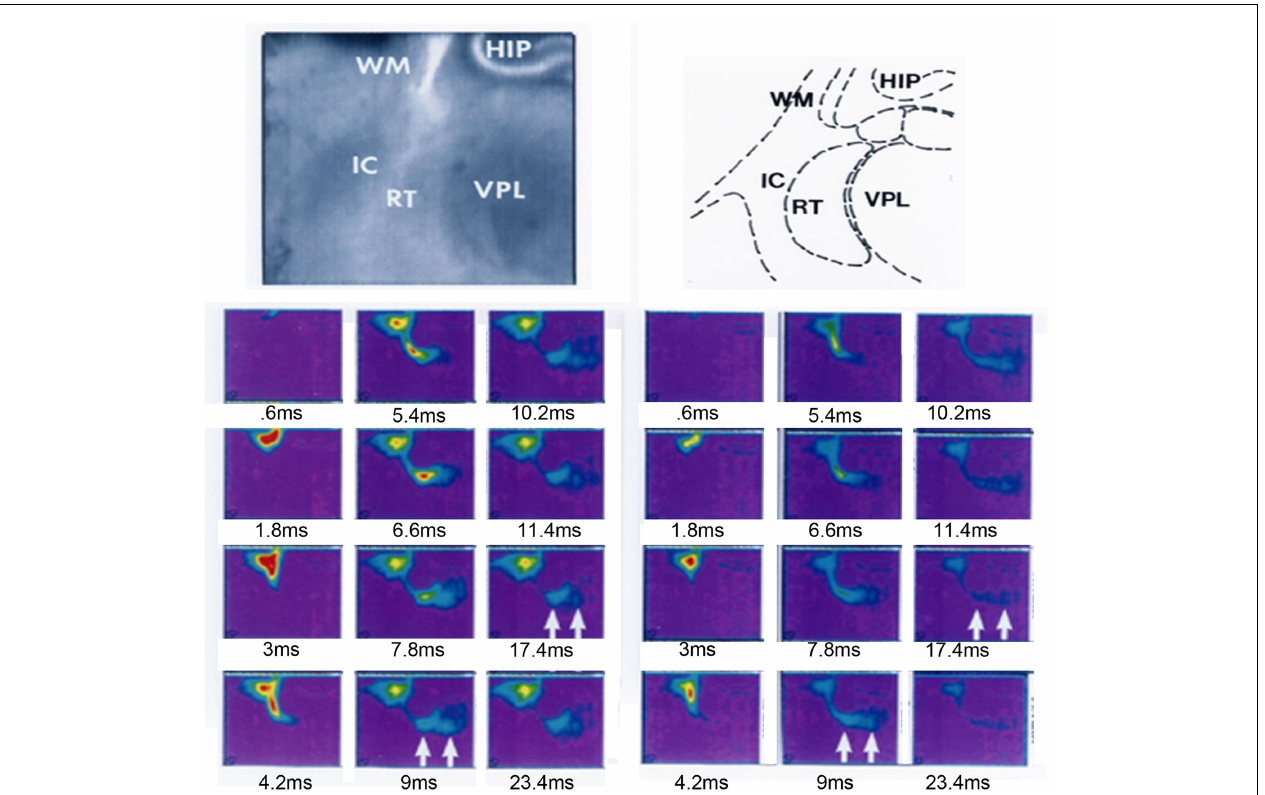
FIGURE 8 | Functional synapses revealed in the reticular thalamic nucleus after cortical stimulation in a thalamocortical slice from a P2 rat. A thalamocortical slice was prepared and stained with voltage sensitive dye RH482 according to the protocols previously described in Higashi et al. (2002, 2005).The slice was positioned to be able to observe the internal capsule, reticular thalamic nucleus (labeled RT in panels), part of the thalamus (VPL) and hippocampus (HIP). A stimulating electrode was placed into the white matter below the primary somatosensory cortex. Stimulus-induced changes in the intensity of transmitted light (700 ± 30nm) were collected with a 128 × 128 pixel array of photosensors (70 μ m 2 /pixel) every 0.6ms (Fujifilm HR Deltaron 1700, Japan) for up to 300ms (each pixel measured the change in